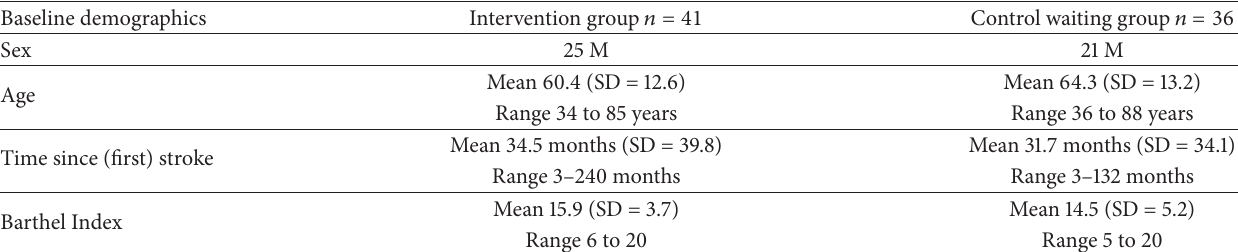
Table 1: Baseline